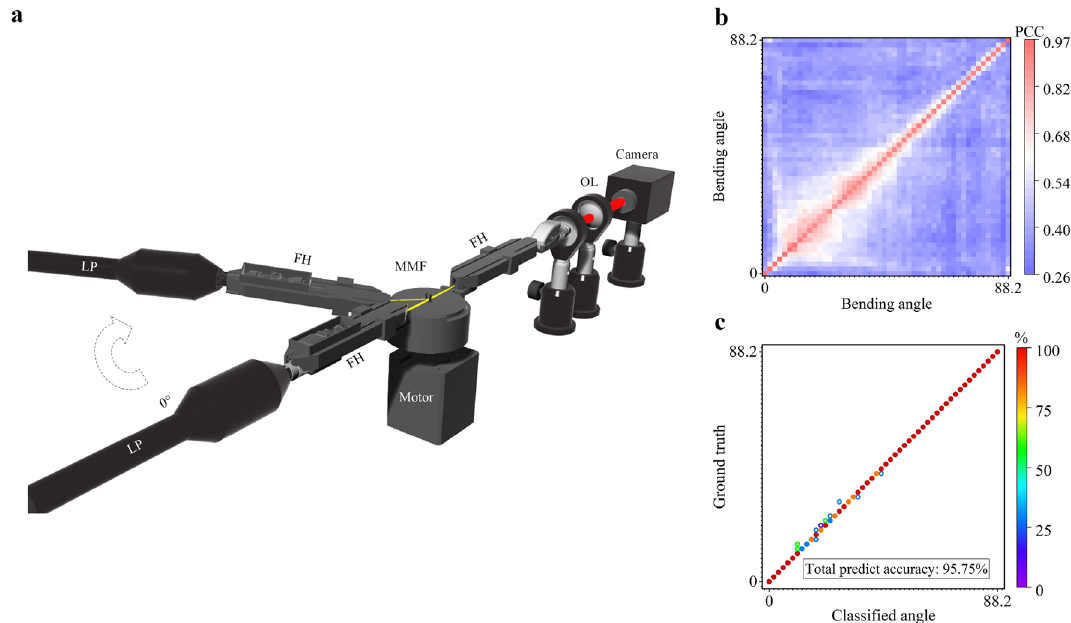
Figure 2. ( a ) Experimental setup for one-point motor bending angle classification. ( b ) Average PCC for one-point motor bending (the average PCC compared themselves with all pictures in other angles). ( c ) The KNN prediction result with 50% dataset as the training data. The colored circles in c indicate the location and percentage of classification errors while the solid circular dots on the diagonal show the classification